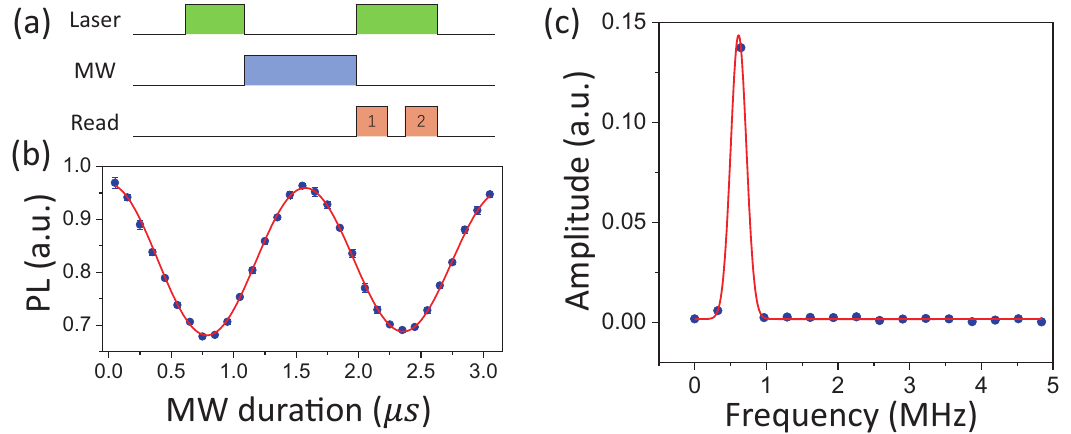
Figure 3. ( a ) Rabi frequency measurement sequence. A first green pulse of 3 µ s was applied to initialize